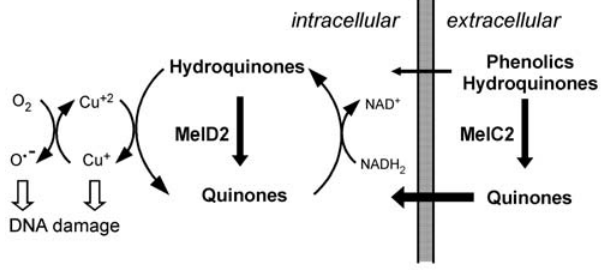
Figure 6. Model for the effect of melC and melD on sensitivity to phenolic compounds. The intracellular spontaneous quinone-hydro- quinone redox cycle is depicted on the left. The proposed oxidation of hydroquinones to quinones by MelD2 is indicated by the vertical thick arrow. Extracellularly, the relative permeability of the hydroquinones/ phenolics and the quinones is represented by the thin and thick horizontal arrows, respectively. Conversion of the phenolics/hydroqui- nones to quinones by MelC2 is indicated by the vertical thick arrow. See text for further details.